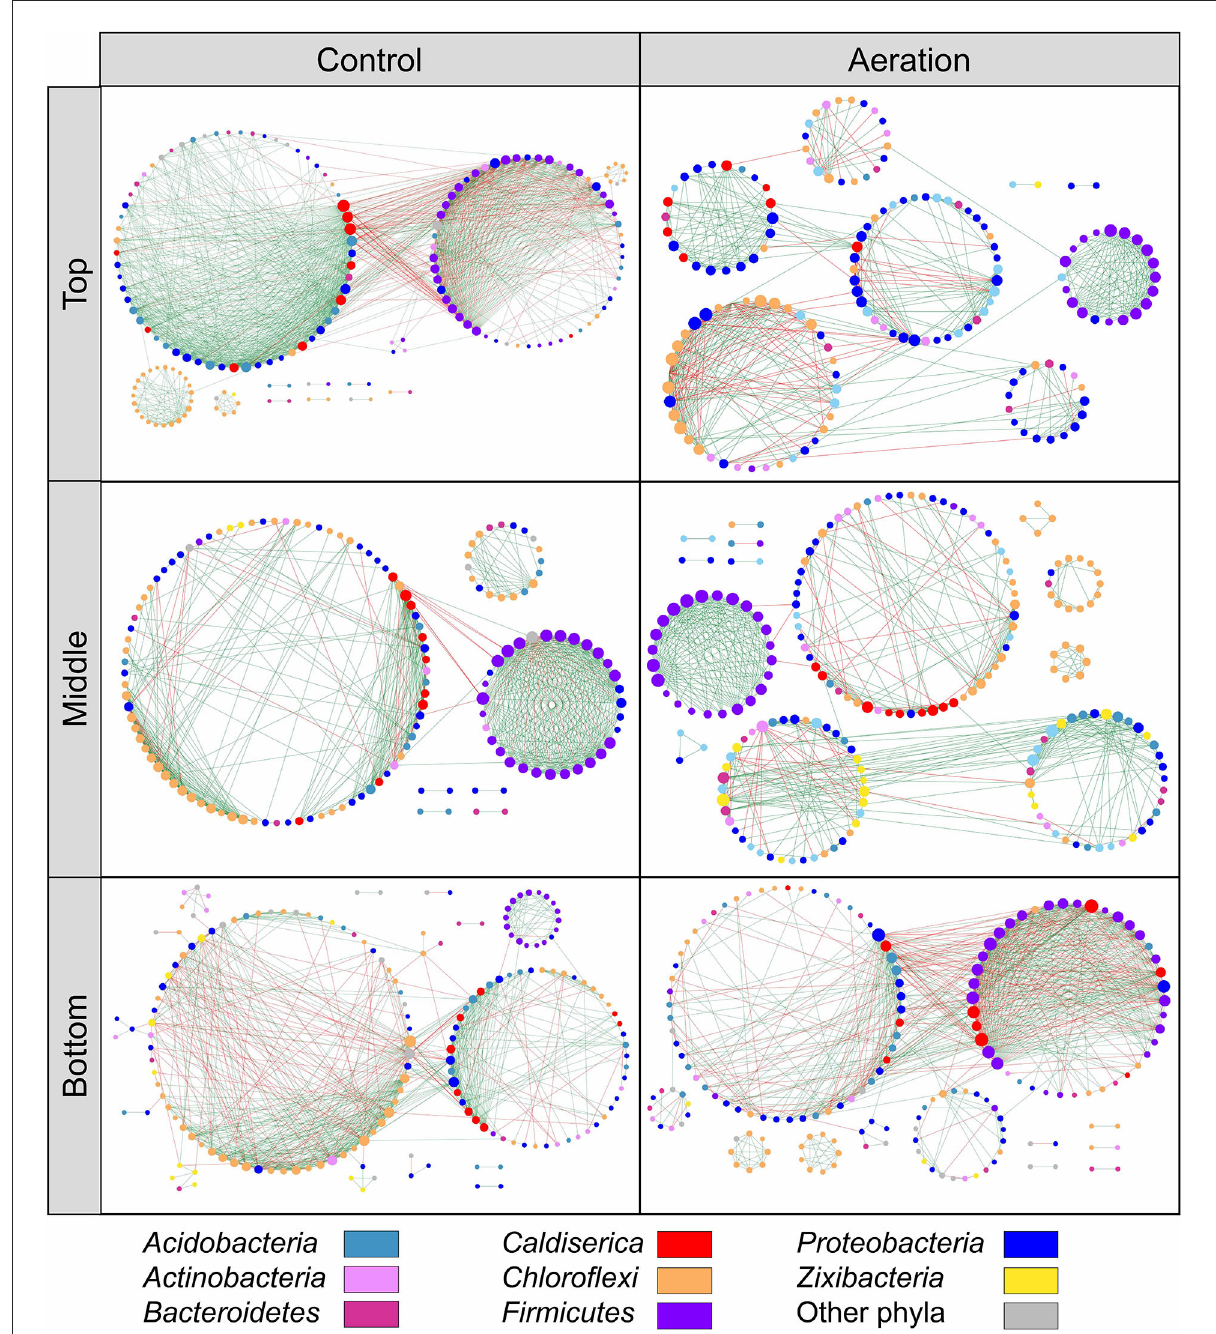
FIGURE1 Depth-wise pMENs showing significant abundance covariations of sediment microorganisms at the top, middle, and bottom layers under aeration. Each node represented an ASV in different modules. Major contributing phyla were colored. Node size was proportional to node degree. A link represented a significant Spearman’s Rho rank correlation between two nodes, green for positive and red for negative correlations.